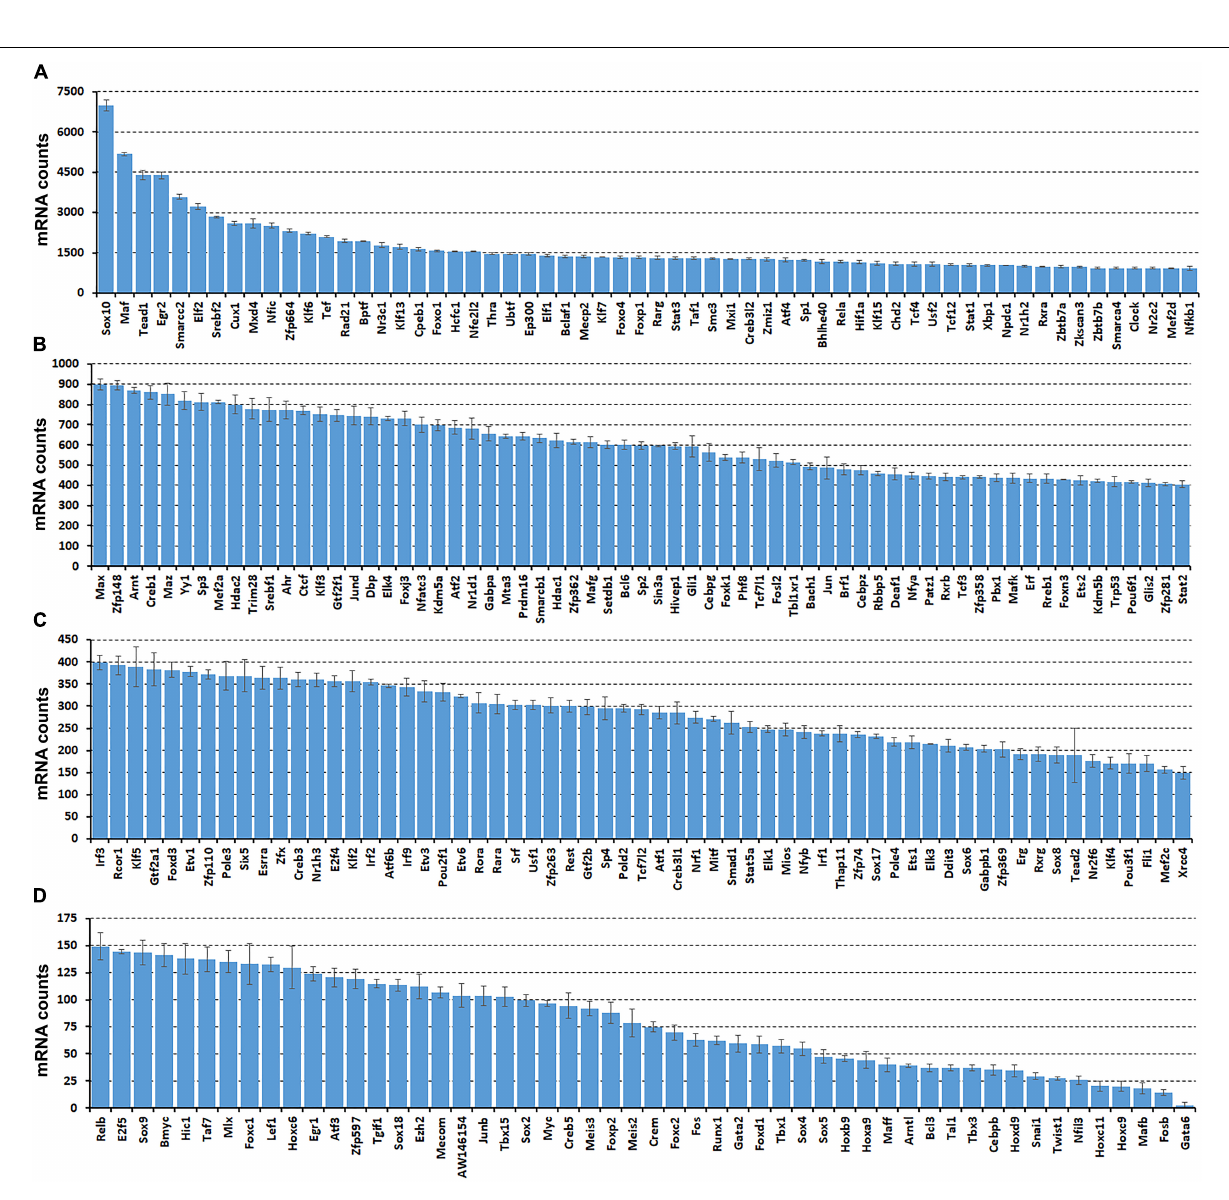
Frontiers in Cellular Neuroscience |